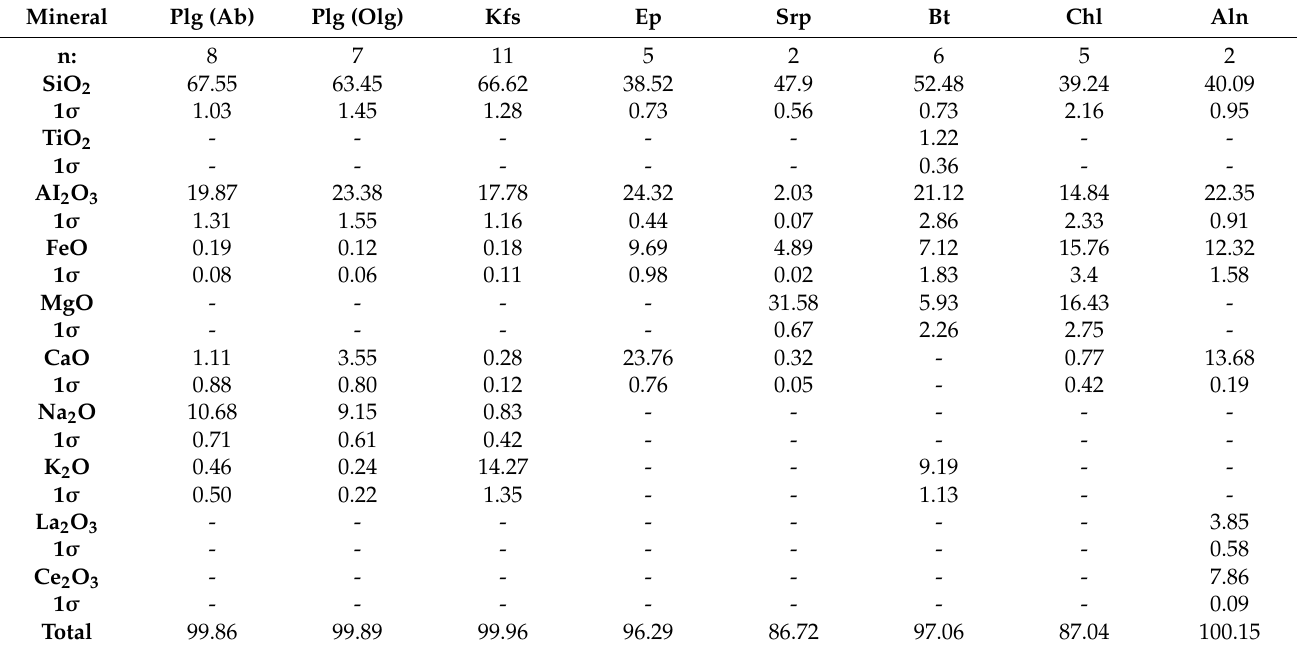
Table 2. Average and 1 σ standard deviation mineral chemistry values of selected sandstone samples from the Northern Eptachori Formation. Abbreviations: Plg: plagioclase, Ab: albite, Olg: